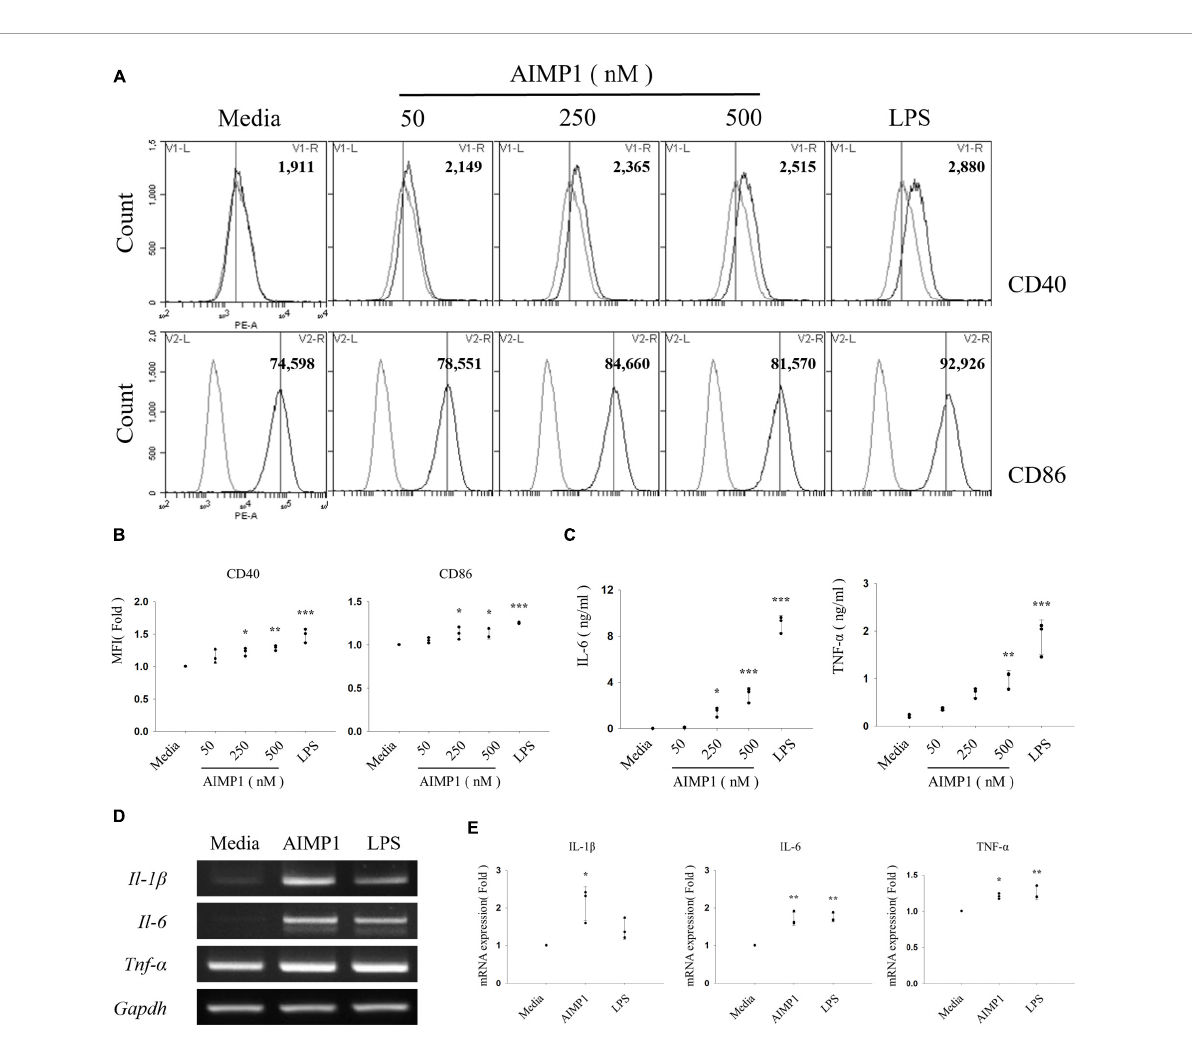
FIGURE2 ARS complex-interacting multifunctional protein 1 (AIMP1) increases the expression levels of surface markers and pro-inflammatory cytokines in BV-2 microglial cells BV-2 cells were cultured with AIMP1 or LPS (100 ng/mL) for 24 (A–C) and with AIMP1 (250 nM) for 6 h (D,E) . (A) The values of histograms indicate the MFI of CD40 and CD86 in CD11b + -gated microglia. (B) Scatter plots represent the fold ratio based on the MFI of each surface marker in the medium group. The data represent the mean ± SD of three independent experiments. (C) Secretion of IL-6 and TNF- α was analyzed using ELISA. Scatter plots show the mean ± SD of three independent experiments performed in triplicate. (D) mRNA expression levels of pro-inflammatory cytokines were quantified using RT-PCR. GAPDH served as a control. (E) Scatter plots represent the fold ratio of mRNA expression in each group compared to that in the medium group. The data represent the mean ± SD of three independent experiments. Statistical significance was evaluated using one-way ANOVA with a Bonferroni post hoc test for multiple comparisons; * P < 0.05, ** P < 0.01, and *** P < 0.001 compared to the medium